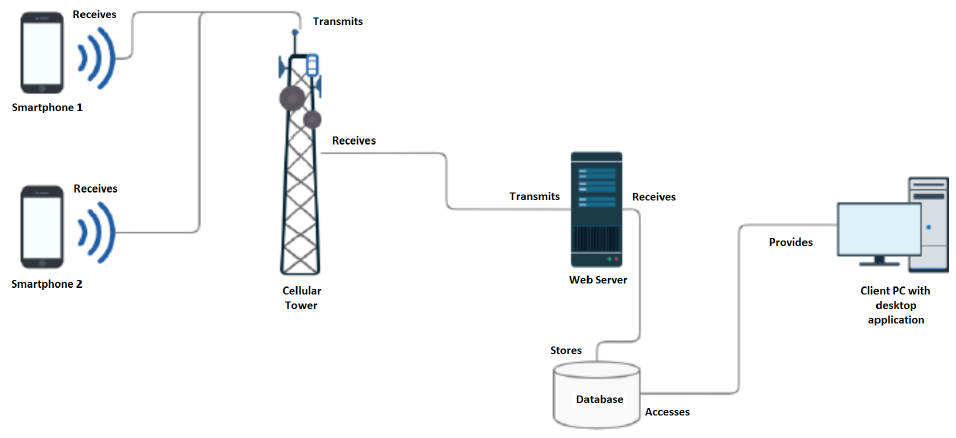
Figure 8. System interaction